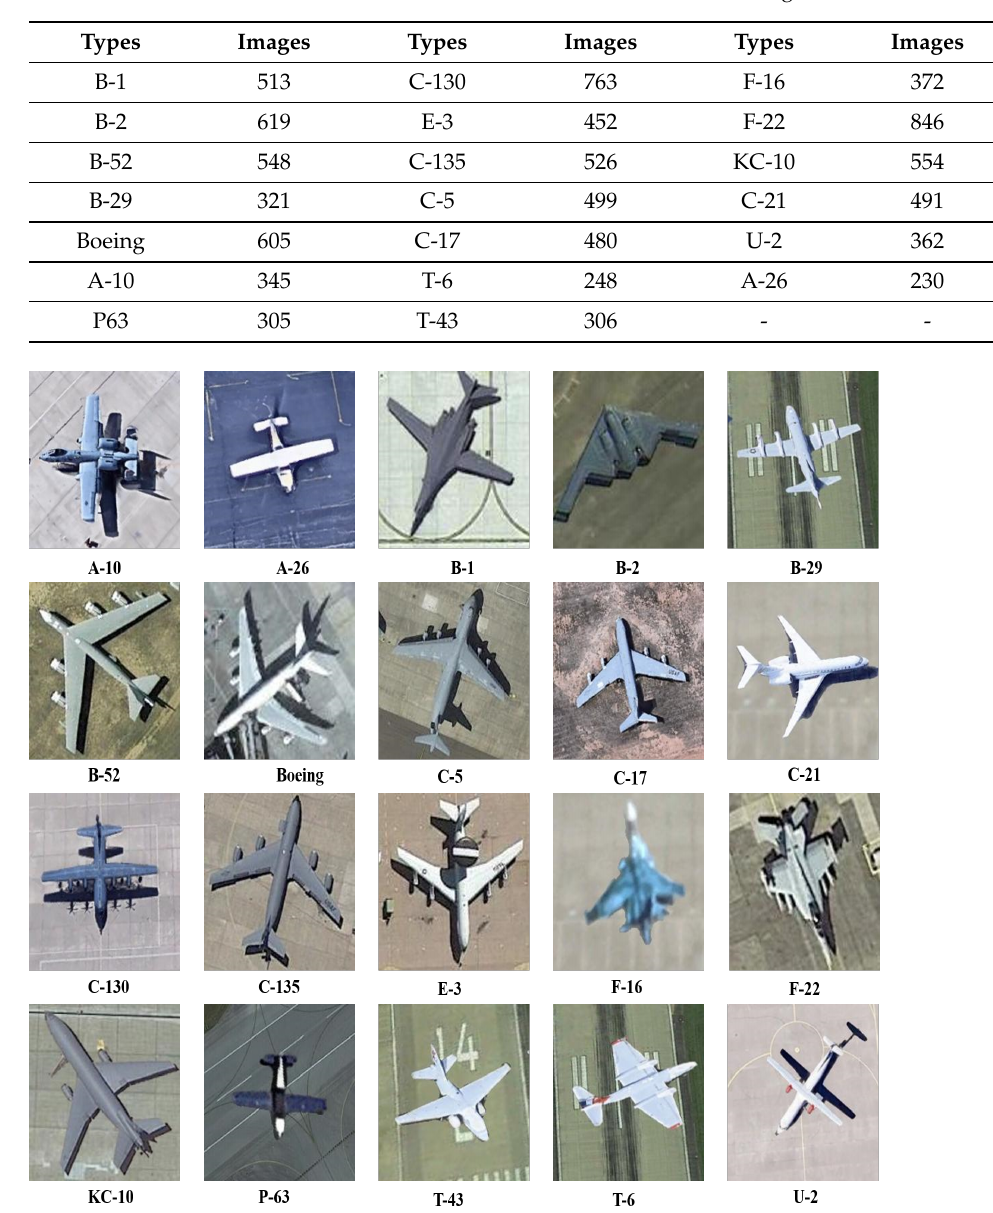
Table 1. MTARSI has different aircraft classes and a different number of images for each class.